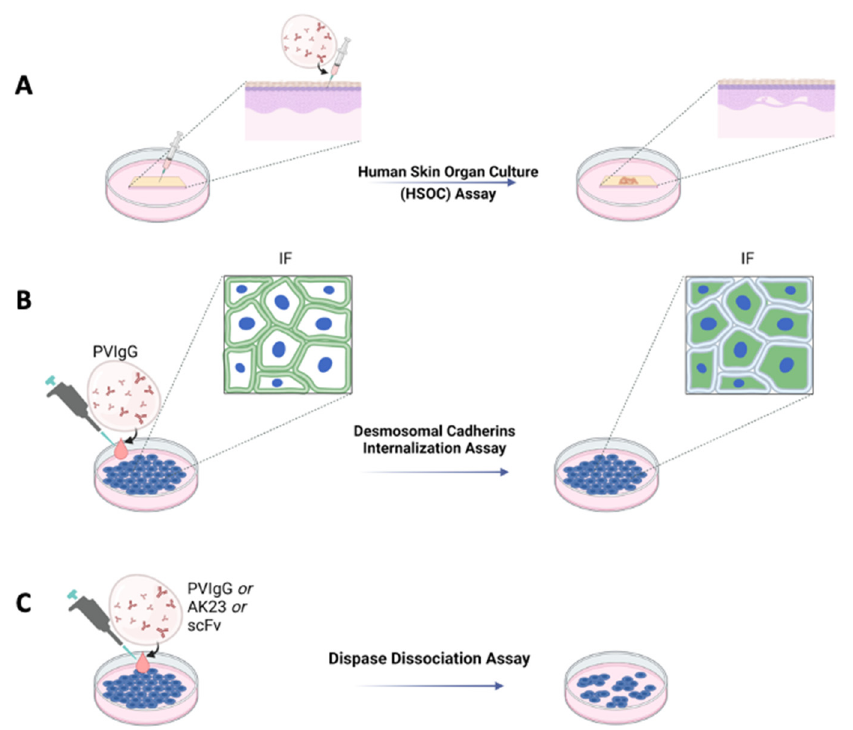
Figure 1. Ex vivo and in vitro schematic representations of Pemphigus models. ( A ) Ex vivo model with human skin organ culture (HSOC) assay. IgG fractions prepared from patients’ sera (PVIgG), or other engineered anti-DSG3 and/or DSG1 antibodies (i.e., scFv), are injected subcutaneously into human healthy skin. Blisters showing the typical histology observed in patients appear after 24 h. ( B ) In vitro desmosomal cadherins internalization assay in normal human keratinocyte or HaCaT culture monolayers. ( C ) In vitro with dispase dissociation assay. IgG fractions prepared from patients’ sera (PVIgG), or monoclonal antibodies directed against desmoglein 3 (DSG3) (i.e., AK23) or other engineered anti-desmoglein 3 (DSG3) and/or DSG1 antibodies (scFv), are used in normal human keratinocyte or HaCaT culture monolayers.